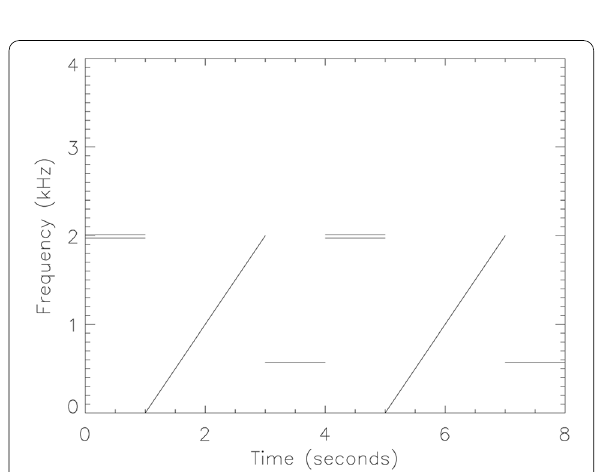
Fig. 3 Pulses and ramp triggered by HAARP during cases 1, 2, and 3